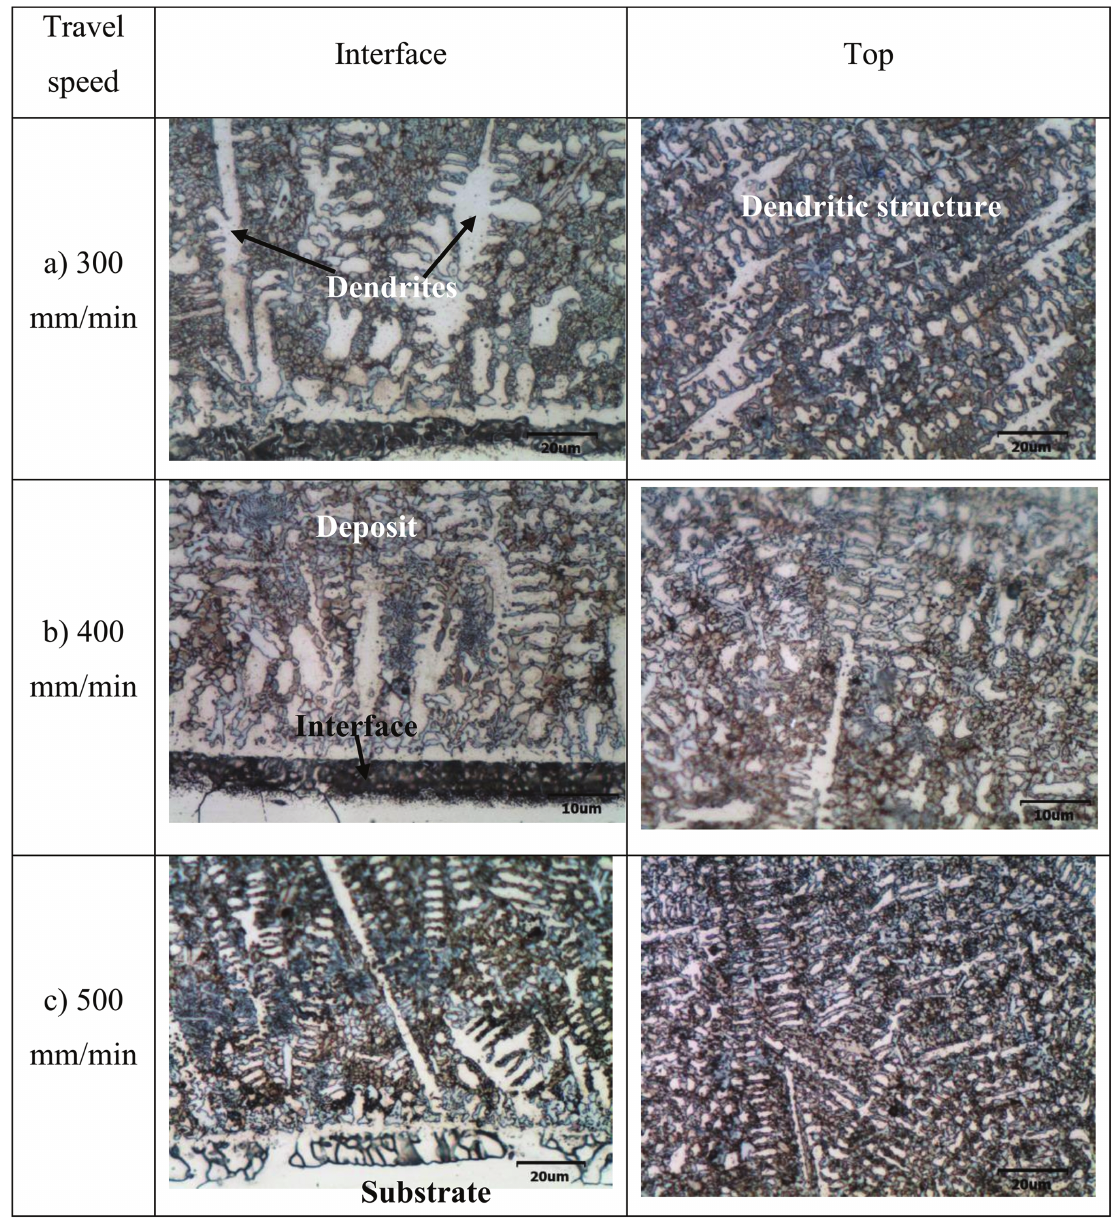
Figure 6: Effect of travel speed on